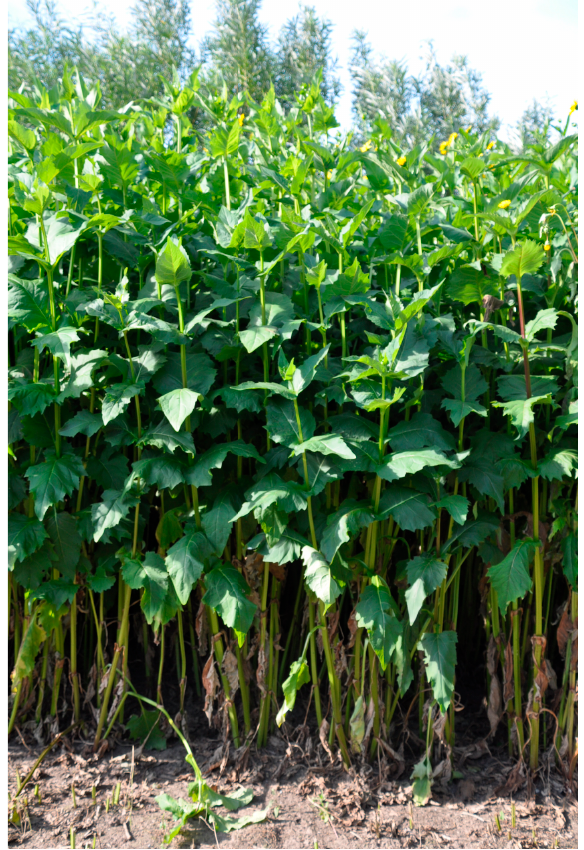
Figure 3. Silphium plants (seeds) in the second vegetation season. Table 5. The number of shoots per plant of Silphium, depending on methods of plantation establishment.